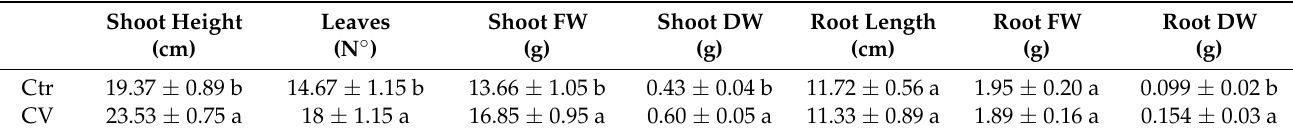
Figure 1. Lettuce seedlings sprayed (CV) and not sprayed (Control) with Chlorella vulgaris extract after 21 days from the first treatment. Table 1. Morphological traits of lettuce seedlings subjected to Chlorella vulgaris extract treatment (CV) by the foliar application after 21 days from the first treatment. Data are means ± SD. The values are the means of data from five plants for each replica. Values in the same column followed by different letters are significantly different ( p < 0.05). Ctr: control; FW: fresh weight; DW: dry